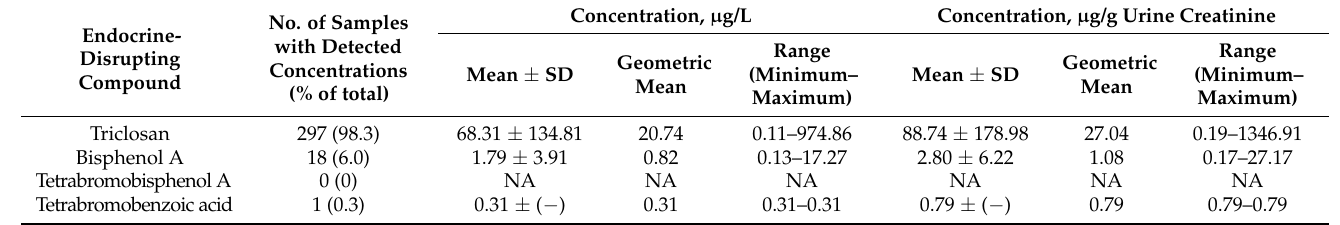
Table 2. Concentrations of endocrine-disrupting compounds detected in the urine of 302 women with newly diagnosed breast